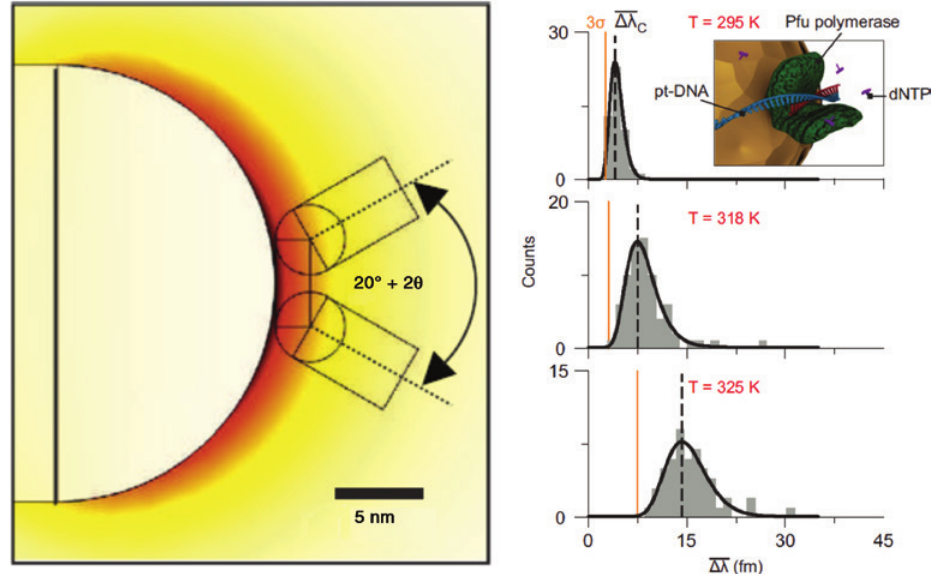
e −i ω t with dissipation of energy at a rate of γ 0 , while their respective resonance frequencies are ω 1 < ω , with destructive interference at higher energies and construc- 1 0 ≈ ω , with destructive interference only. (D) Fano 1 0 > ω , with destructive interference at lower energies and constructive interference at higher 1 0